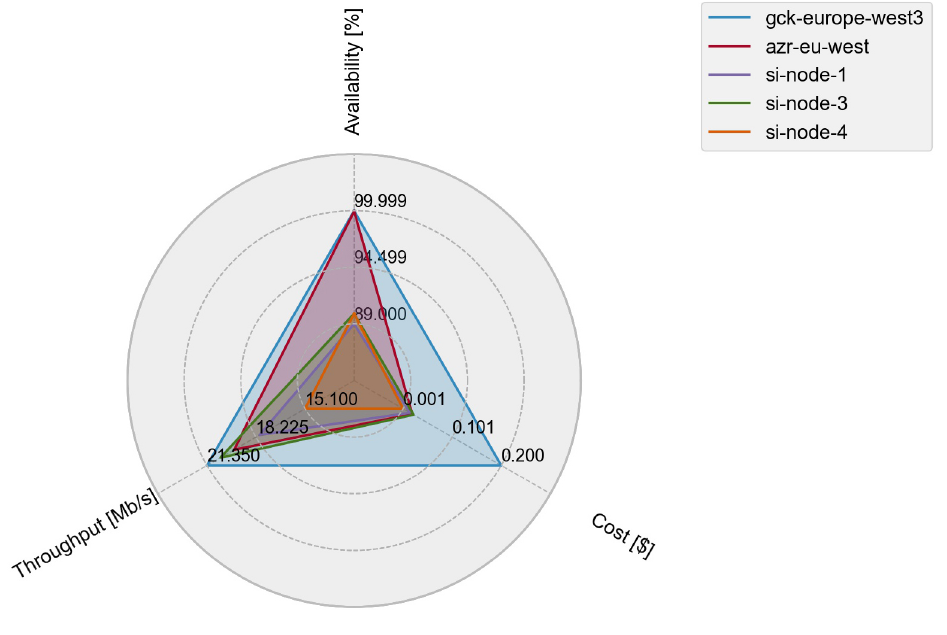
Figure 6. Trade-off between the nodes forming the Pareto